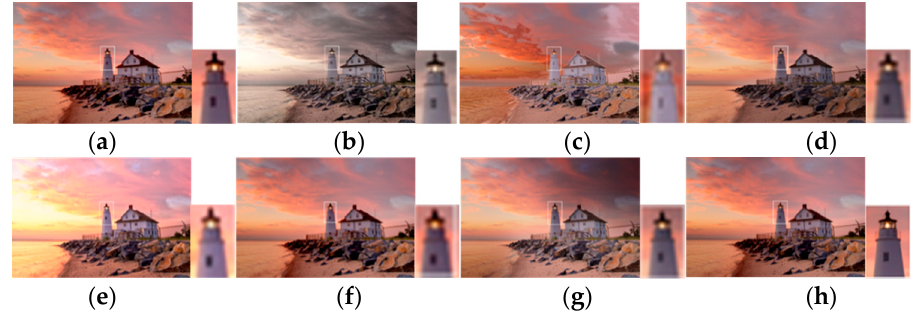
Figure 4. Source image sequences used in experiments. ( a ) “Lighthouse”, 340 × 512 × 3; ( b ) “House”, 340 × 512 × 4; ( c ) “Studio”, 341 × 512 × 5; ( d ) “Candle”, 364 × 512 × 10; ( e ) “Garden”, 754 × 1024 × 5.